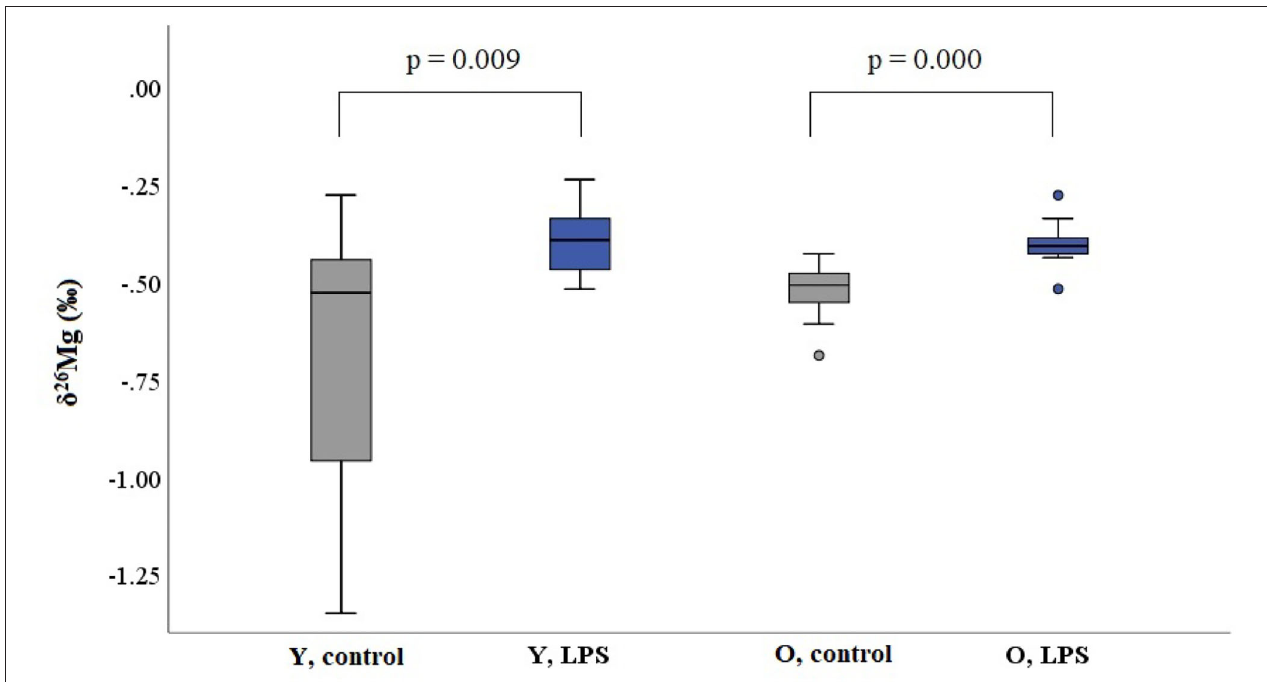
FIGURE 1 | Boxplots for the blood plasma Mg isotopic composition for young and aged LPS-injected mice and the matched controls. Y and O correspond to young and aged mice, respectively. LPS corresponds to LPS-injected mice. These box plots compile the median, quartiles, and extreme values; individual dots are outliers.